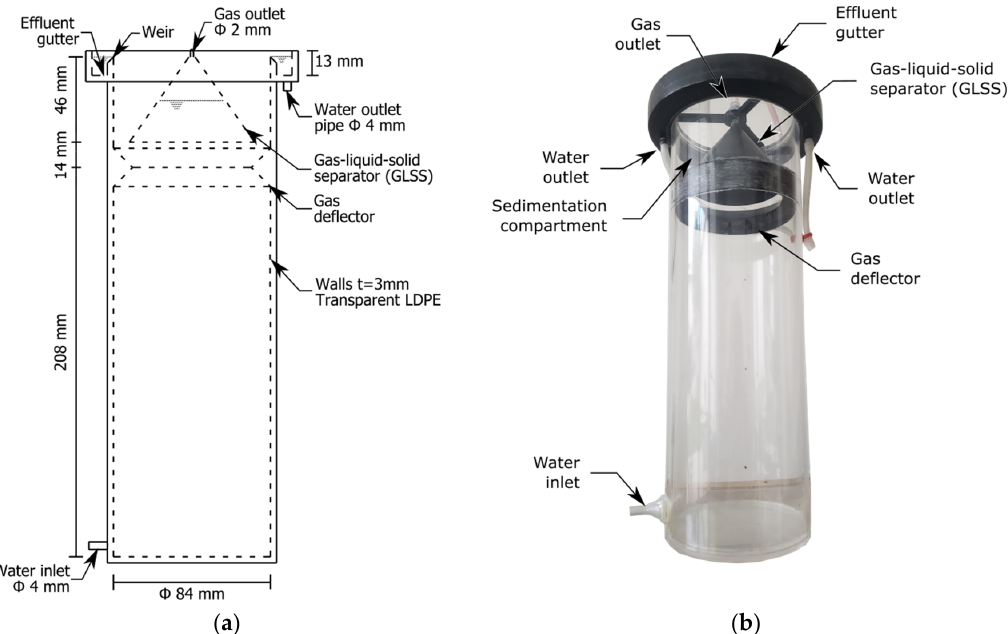
Figure 3. Laboratory-scale UASB reactor. ( a ) Reactor dimensions in cross-section image; ( b ) Picture of the reactor.